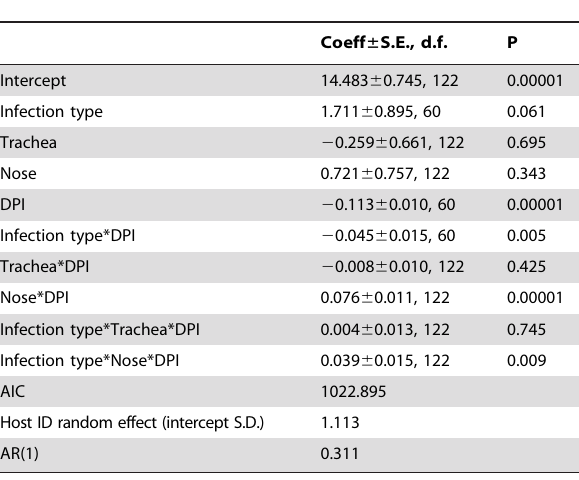
Table 1. Summary of linear mixed effect model (LME) between B. bronchiseptica abundance (CFU/g), as a response, and infection type (single or co-infection), day post infection (DPI) and organ (lung, trachea or nose) as independent